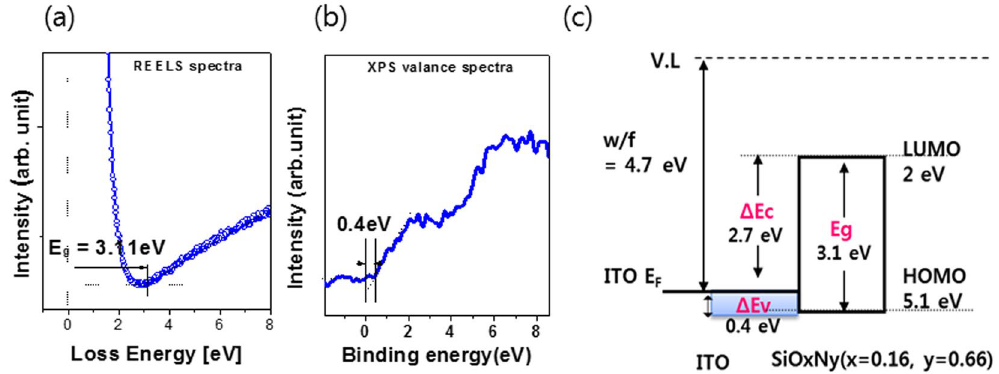
Figure 3. ( a ) REELS spectra ( b ) valance band spectra and ( c ) Energy band diagrams for the S2